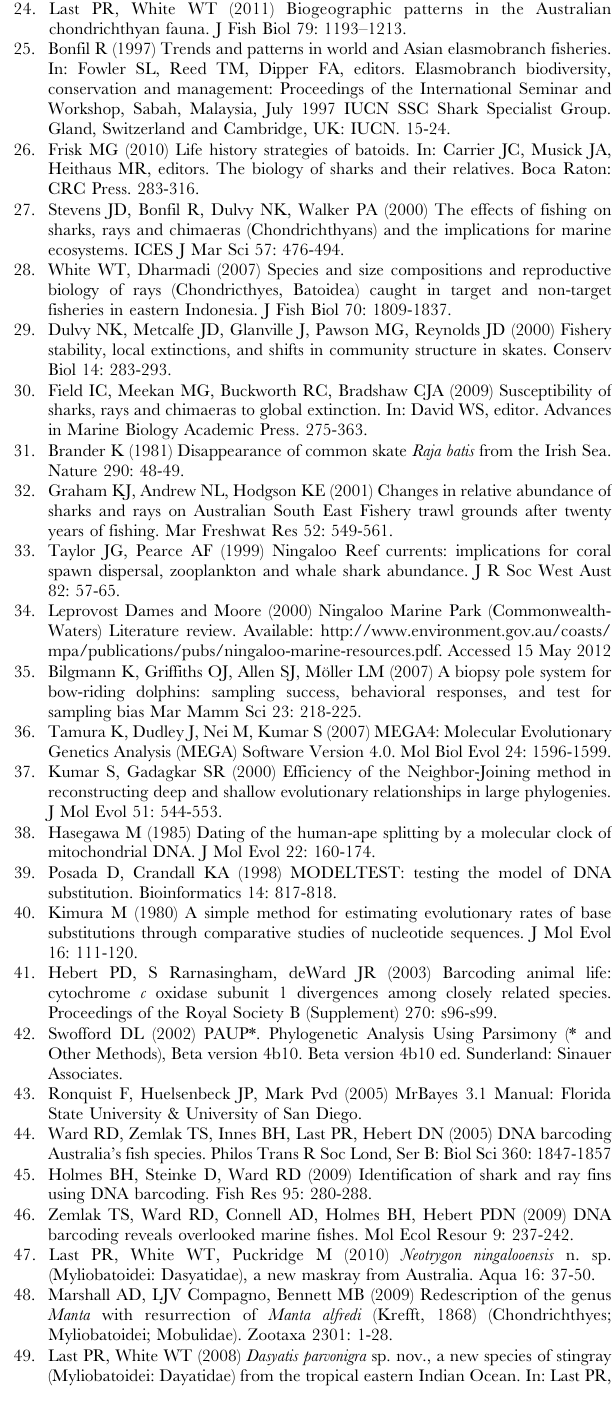
Table S3 Online sequences used in this study with their GenBank accession